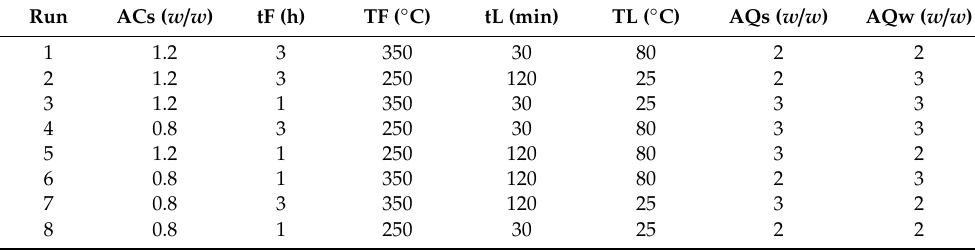
Table 2. Plackett–Burman design—screening experiments ( w / w : mass /